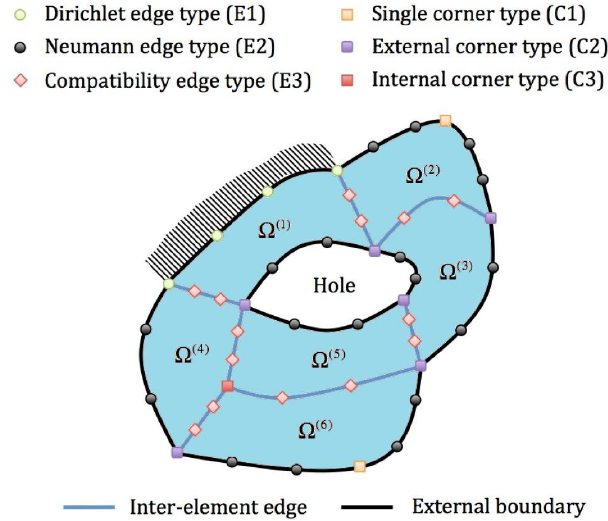
Figure 3: Internal and external boundary conditions for element edges and corners.